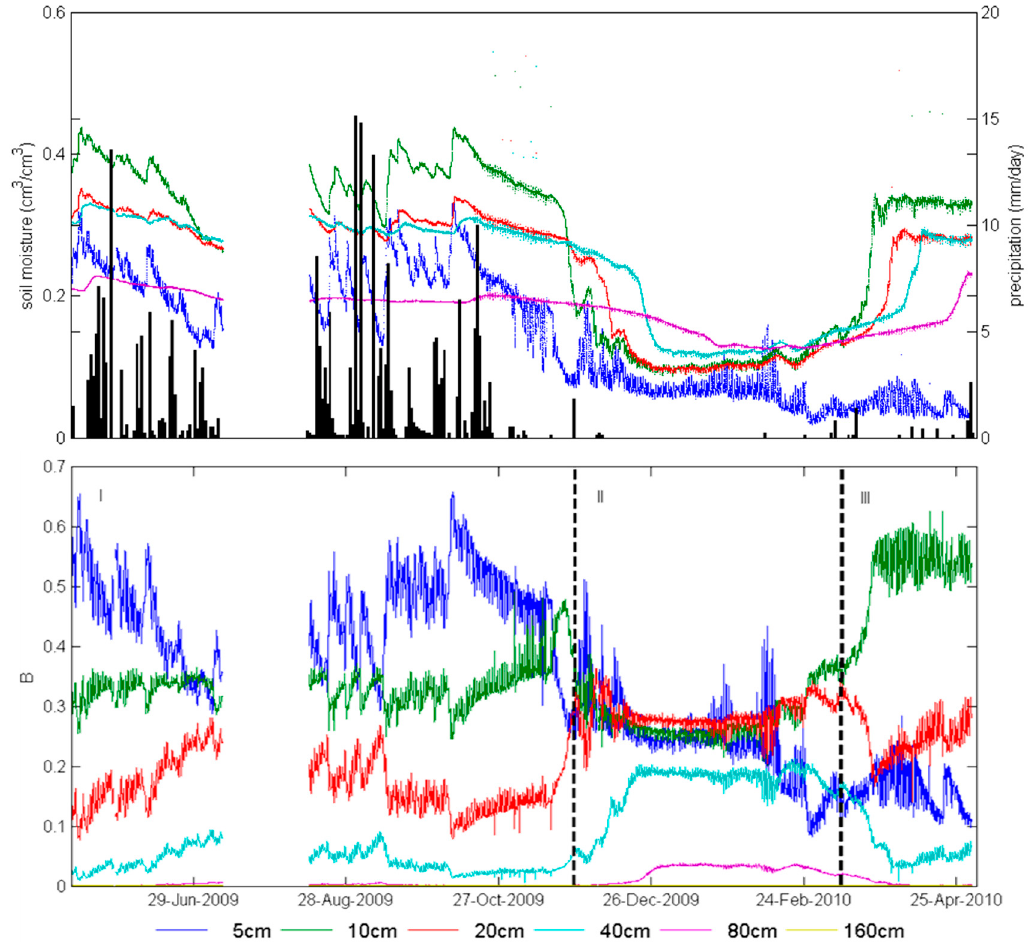
Figure 3. The soil moisture and rainfall time series at the center station ( upper panel ); the B values for the six layers using Lv’s multilayer scheme ( bottom panel ). The time series is divided into three periods: April 2009–mid November 2009 (Period I); mid November 2009–March, 2010 (Period II); April, 2010 (Period III).